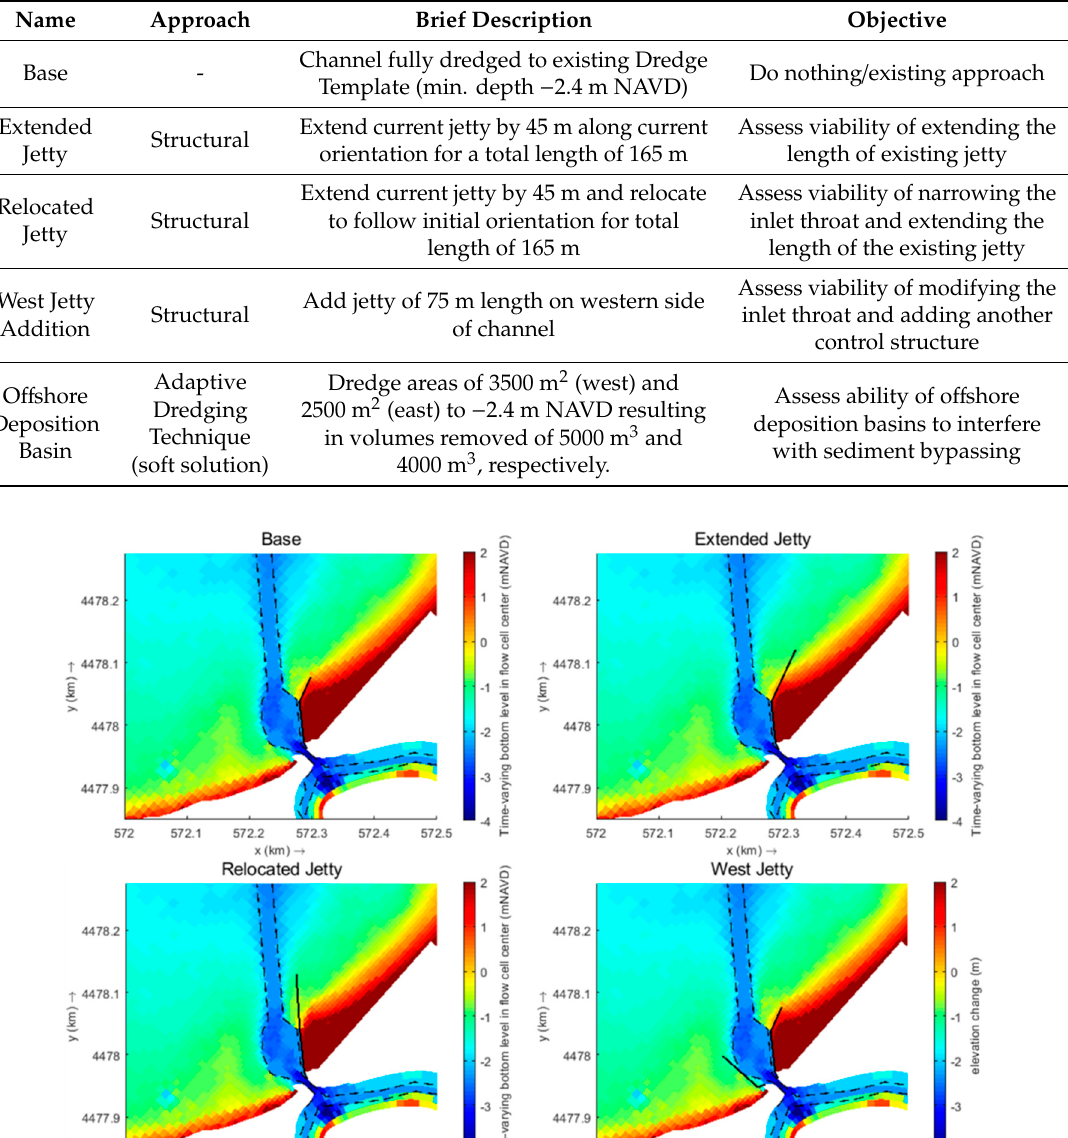
Table 7. Selected alternatives for modeling.